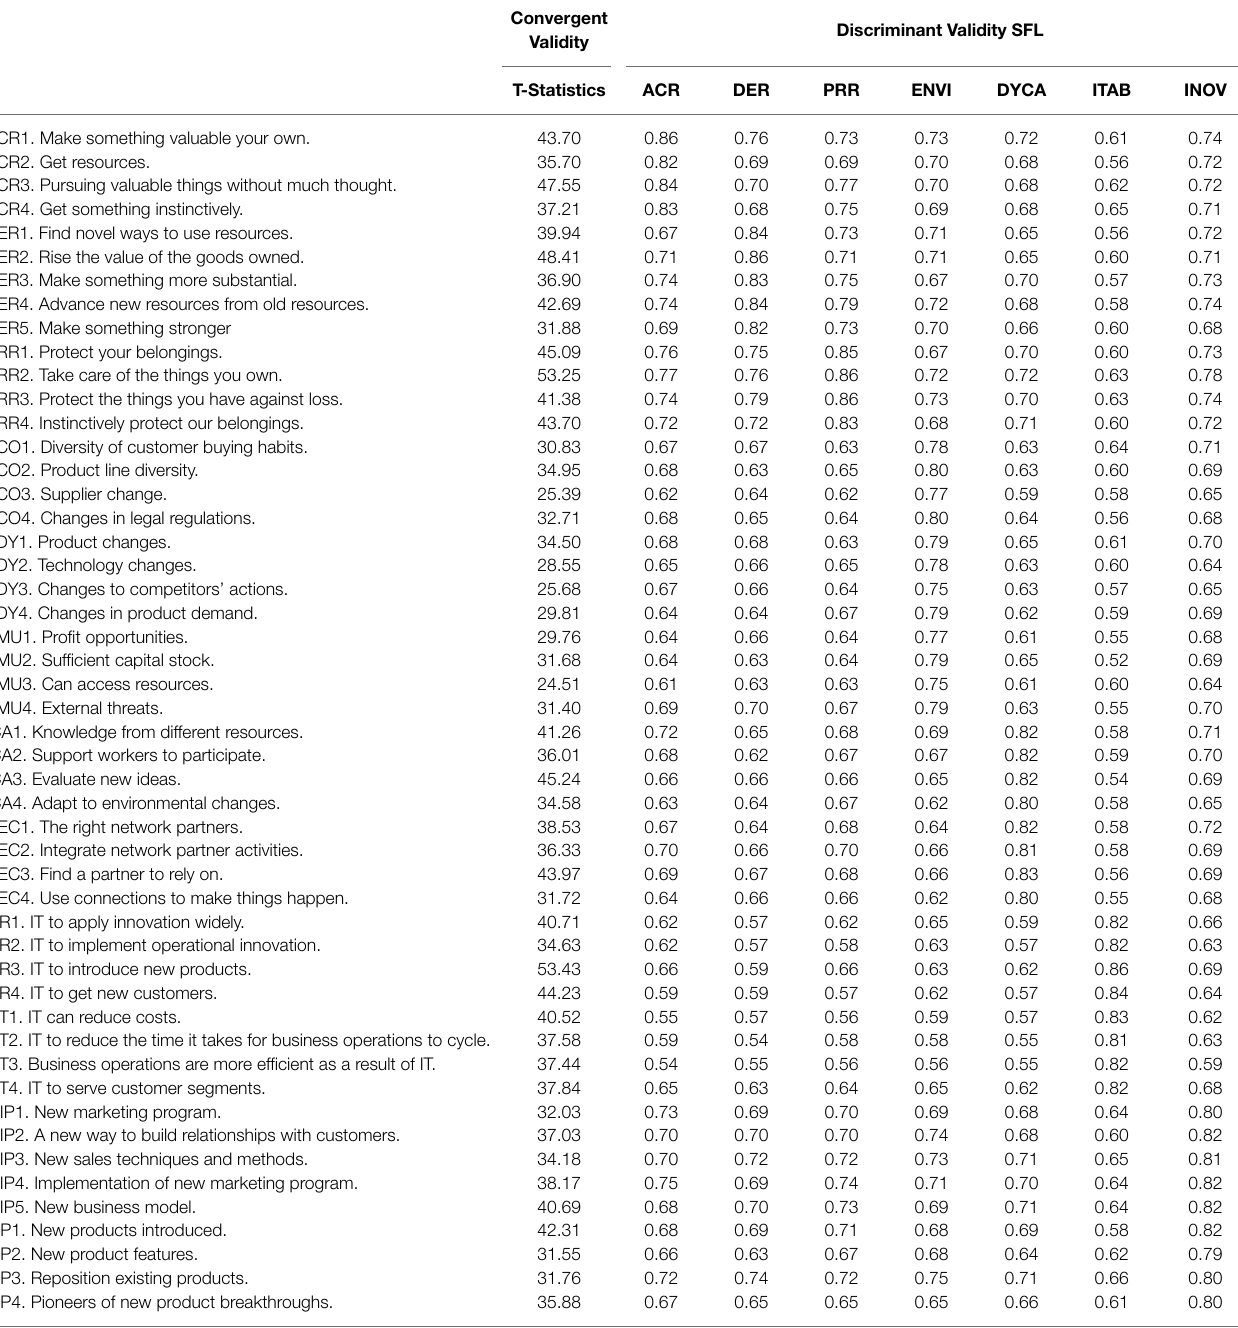
TABLE 1 | Validity test.